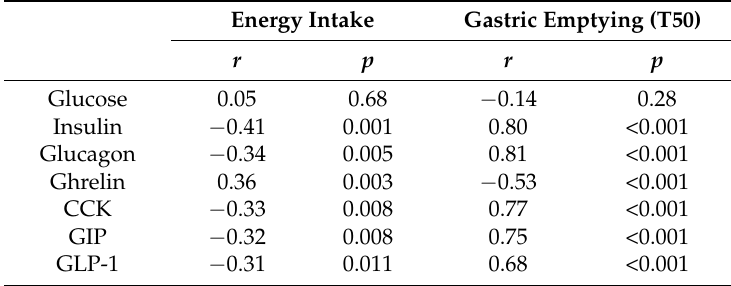
Table 1. Correlations between gut hormones, energy intake, and gastric emptying. Energy Intake Gastric Emptying